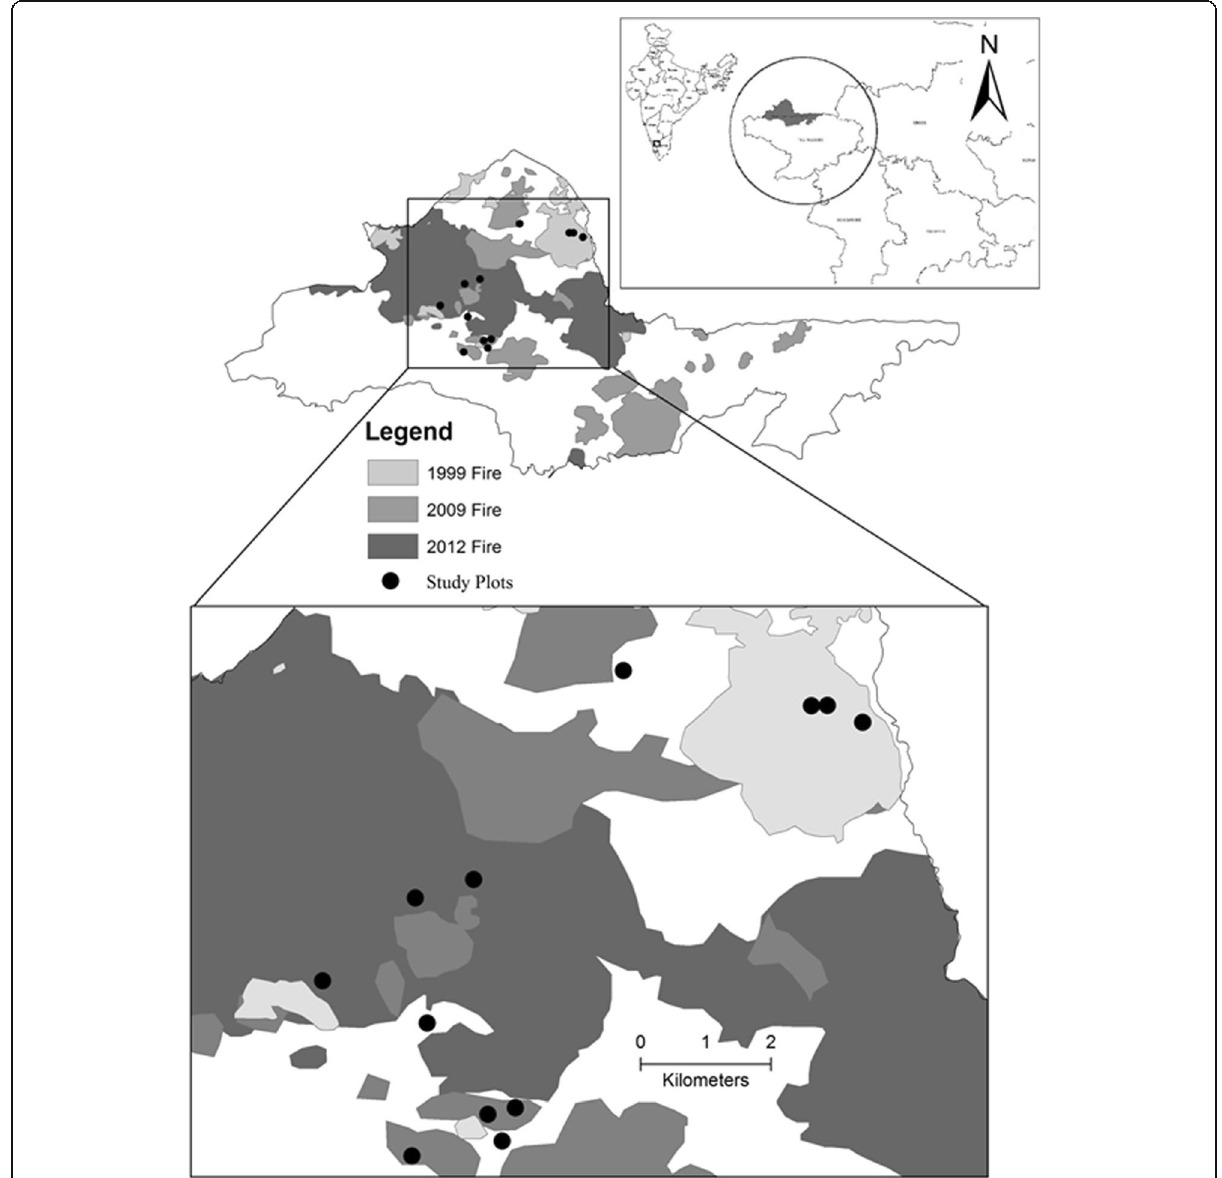
Fig. 1 Location map of Mudumalai Tiger